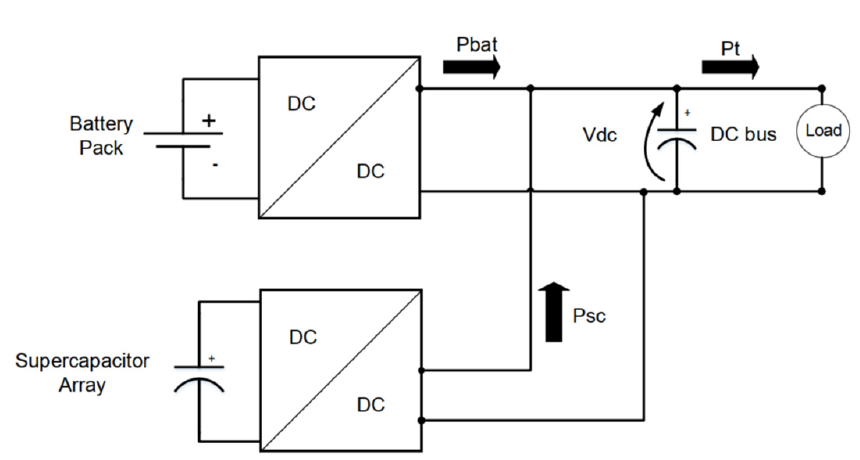
Figure 1. Hybrid energy storage system model.